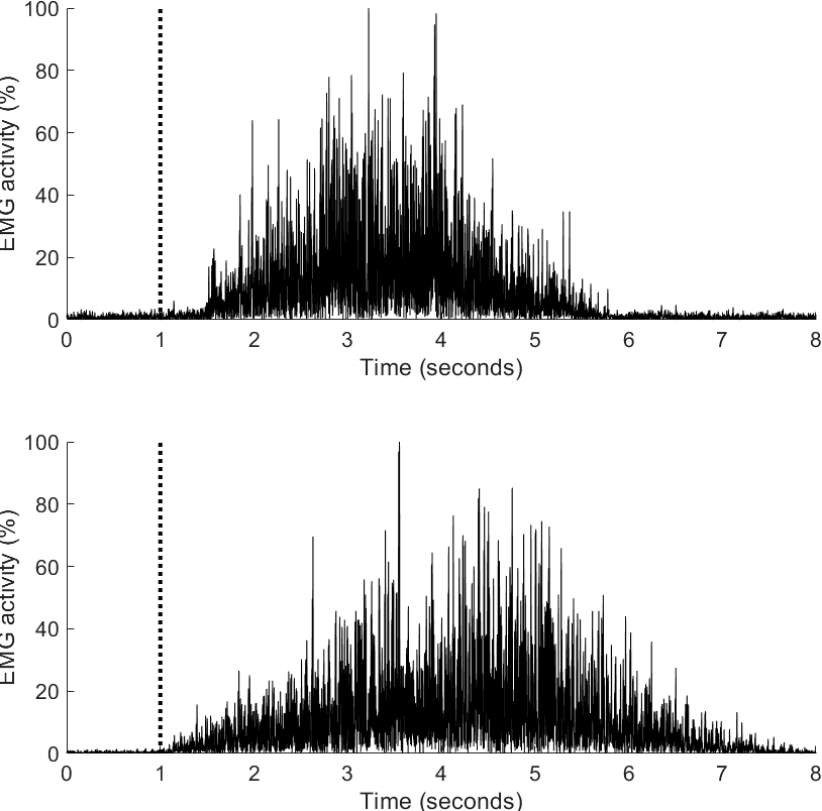
Figure 7. Onset timing of the left tensor fasciae latae muscle during the seated hip flexion task pre-intervention (upper graph) and post-intervention (lower graph). The beginning of the hip flexion (task onset) is denoted by the dotted bold line. The amplitude of the electromyographic signal was normalised to the maximum activity observed during the task.